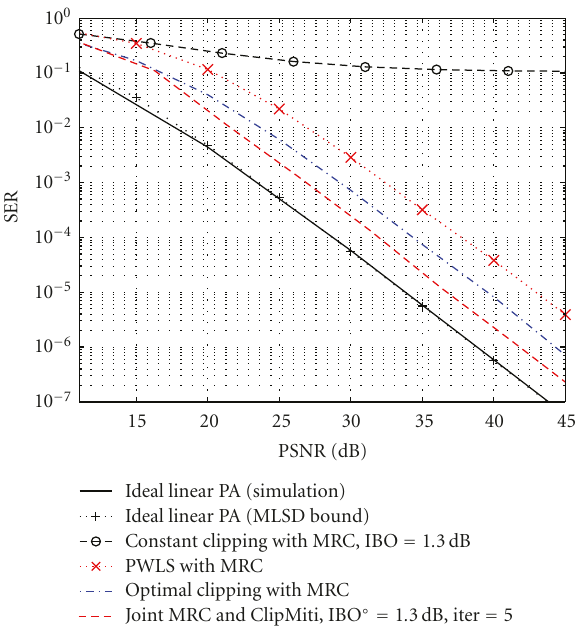
Figure 3: MSE ( q ) versus the number of iterations ( q ) for the d joint MRC and clipping mitigation methods. The corresponding MSE curves of separately using clipping mitigation [29] and MRC methods are also plotted for comparison. IBO = 1 dB, N r = 2, the oversampling ratio L = 1 or 4, and PSNR = 30dB or 40